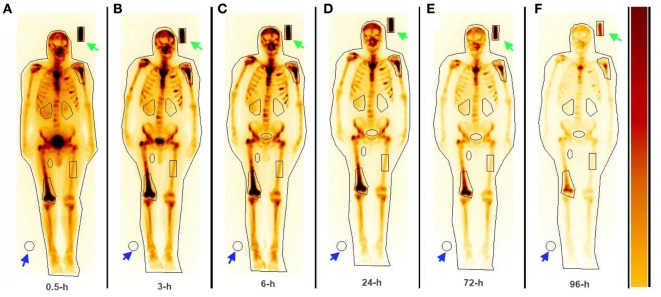
The whole body anterior images acquired using a dual head gamma camera at 0.5, 3, 6 24, 72, and 96 h (A–F) following intravenous administration of 153Sm-EDTMP demonstrating intense localization of the tracer in multiple bone metastatic sites.